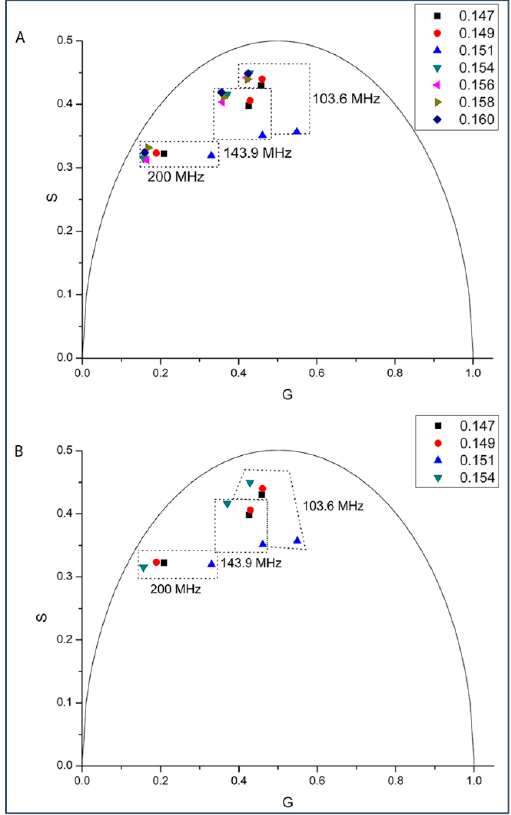
Figure 5. Phasor plot of gramicidin fluorescence lifetime in a sample set of gD/DMPC MLVs with gD content centered around the theoretically predicted critical mole fraction 0.154. Samples were measured at 37 °C using 3 different modulation frequencies (from left to right) 200.0, 143.9 and